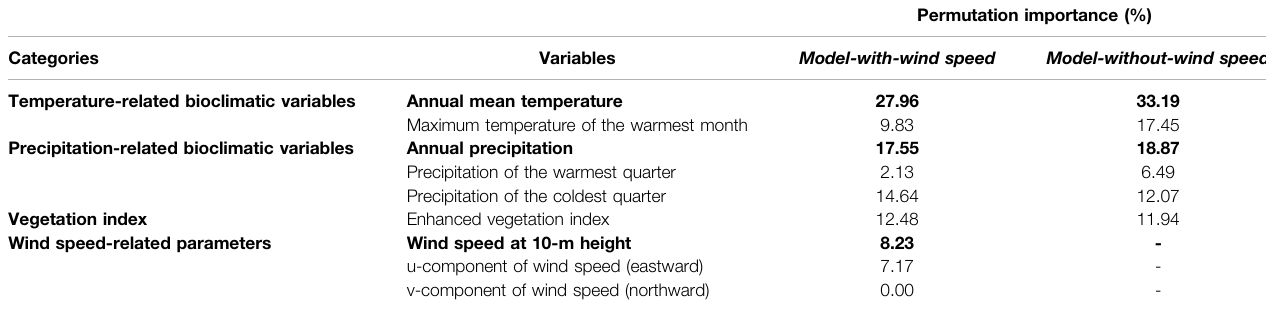
TABLE 1 | Permutation importance (%) of temperature- and precipitation-related bioclimatic variables used in the training of MaxEnt models. The annual mean temperature and annual precipitation arethemost important temperature-related and precipitation-related bioclimatic variablesin both models, followed by theenhanced vegetation index. The most important wind speed-related variable is wind speed. The most important variables in each category are highlighted in bold